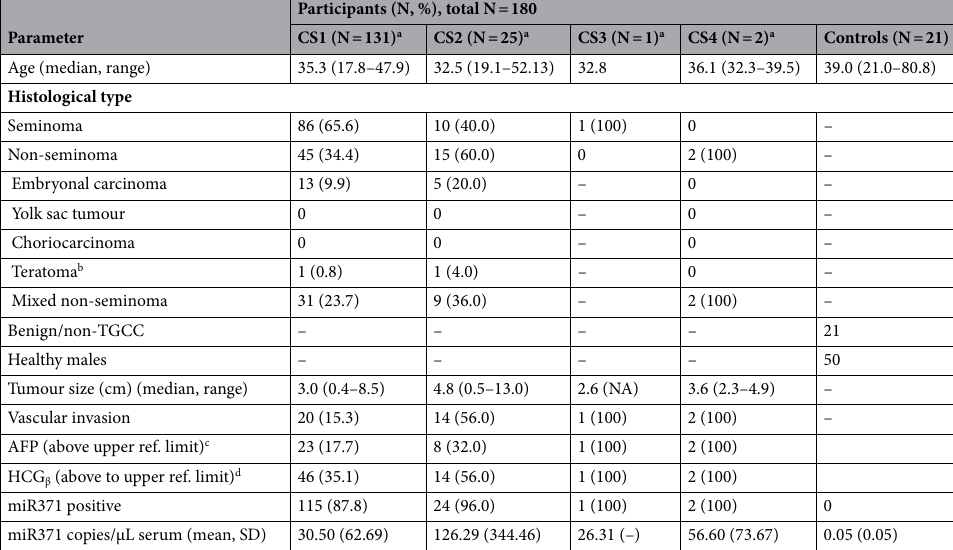
Table 1. Clinicopathological variables for the participants of the study. N number, CS clinical stage, TGCC testicular germ cell cancer, AFP alfa-fetoprotein, hCG β human chorionic gonadotropin. a Clinical stage is according to the Royal Marsden staging system 52 . b Among the 180 included patients, two were pure teratomas, 34 had a teratoma component. c Pre-orchiectomy AFP was missing for 5 patients. d Pre-orchiectomy hCG β was missing for 11 patients.